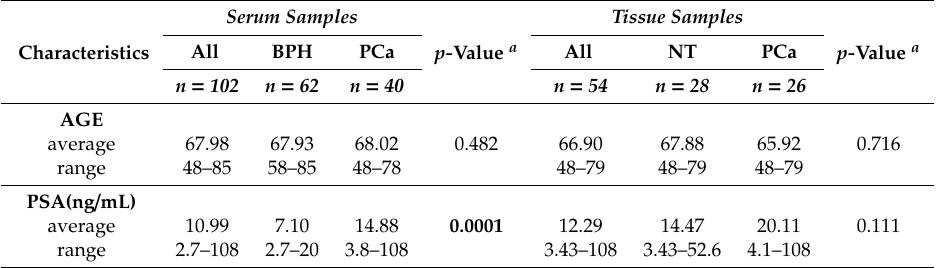
Table 1. Clinicopathological characteristics of the studied